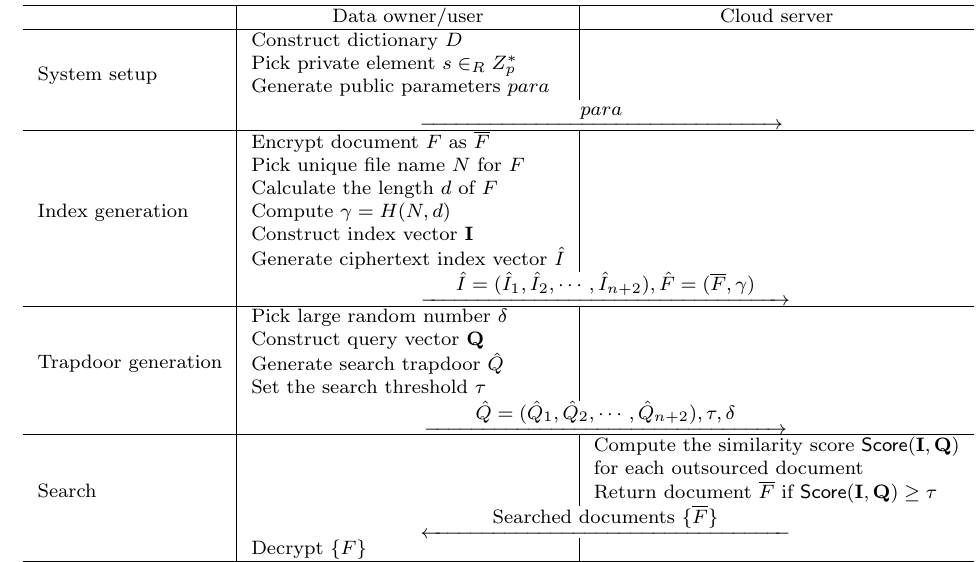
Fig. 3 The execution process of basic PRMS scheme Figure 2. The procedures of basic PRMS